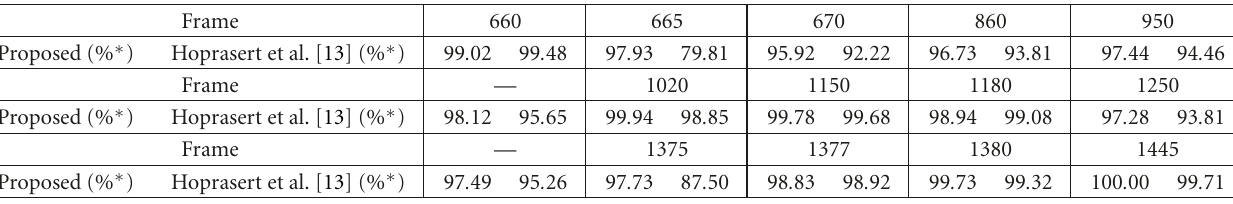
Figure 7: The results of illumination changes with white desk light, the number below the picture is the index of frame, (a) original images, where red indicates the shadow, green indicates the highlight, and blue indicates the foreground, (b) the results of pixel classification, (c) the results of background subtraction with shadow removal using our proposed method, where dark indicates the background and white indicates the foreground. Table 3: The robustness test between the proposed method and that proposed by Hoprasert et al. [13] via local illumination changes with a white desk